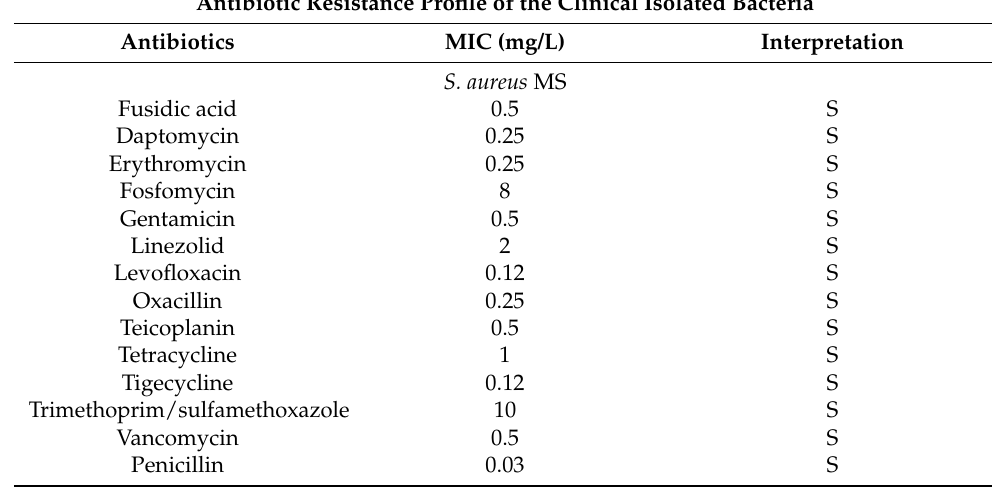
Table 2. Antibiotic resistance profiles of the clinical isolates used in the study